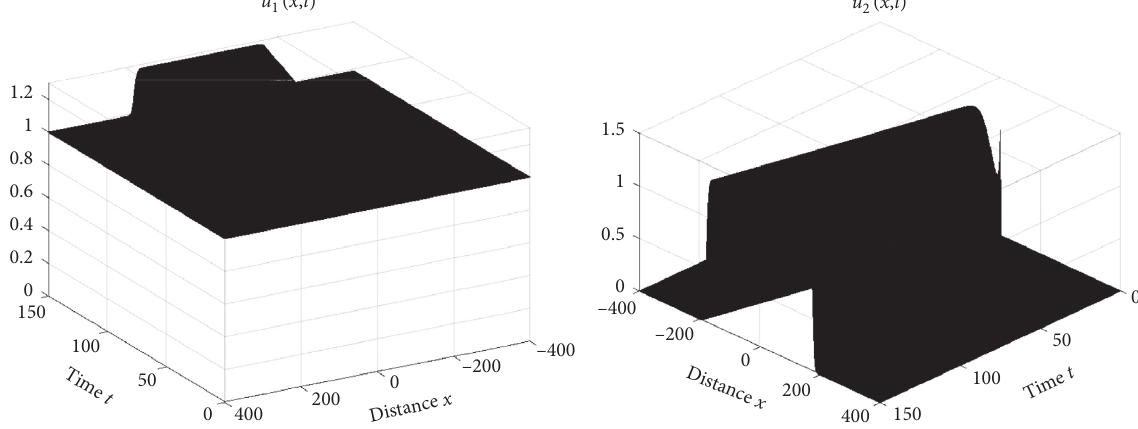
Figure 3: Simulation of ( u